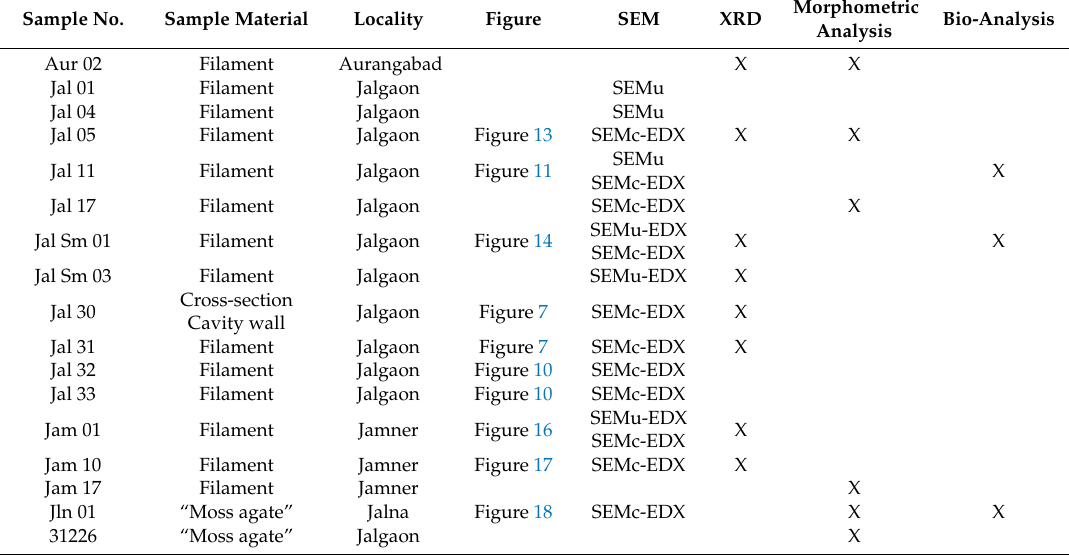
Table 1. Investigated samples from the main volcanic province (India) showing the applied analytical techniques; (XRD = powder X-ray di ff raction; SEM = scanning electron microscopy; EDX = energy dispersive X-ray analysis; SEMu-EDX = scanning electron microscopy of uncoated samples with local chemical by EDX; SEMc-EDX = SEM-EDX of carbon-coated samples; XRD = X-ray di ff raction). Sample